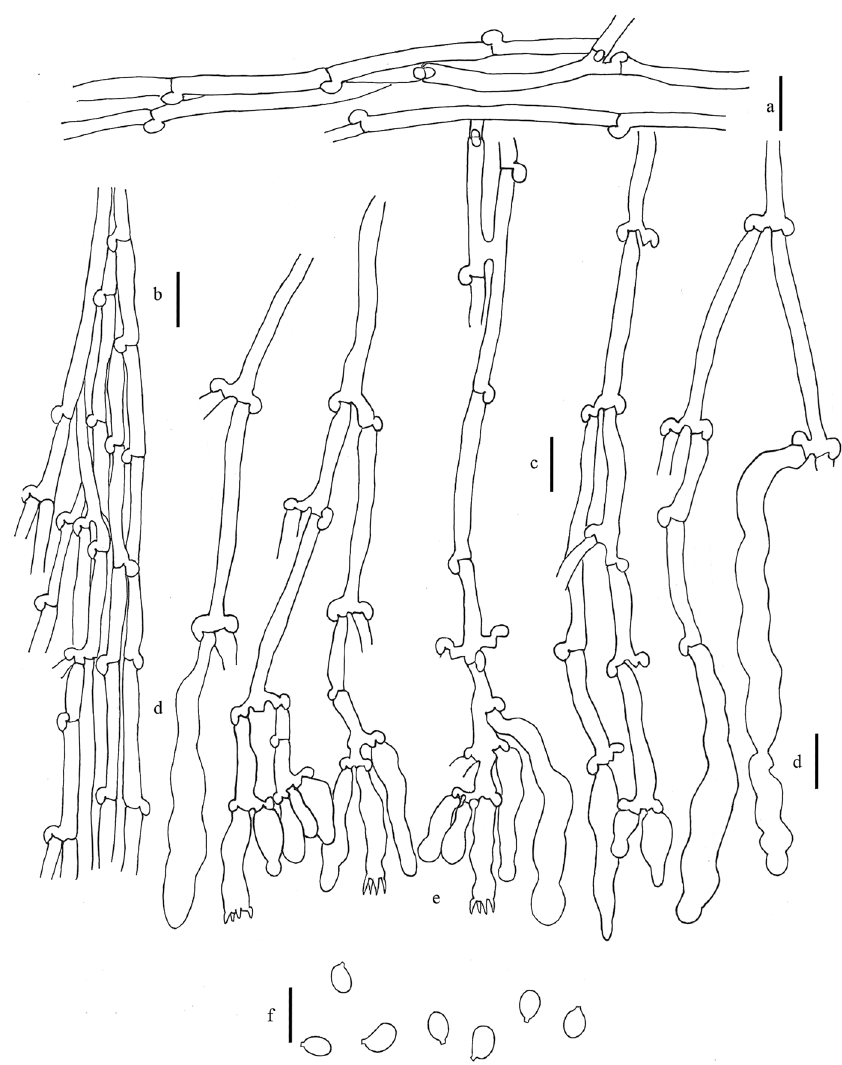
Figure 6. Xylodon lenis , SH Wu 890714-3, H 7027389, isotype. ( a ) Subicular hypha. ( b ) Hypha of aculeus. ( c ) Subhymenial hypha. ( d ) Cystidia. ( e ) Basidia. ( f ) Basidiospores. Bar = 10 µm. Hand-made draws were edited using GIMP v2.10.20 (https